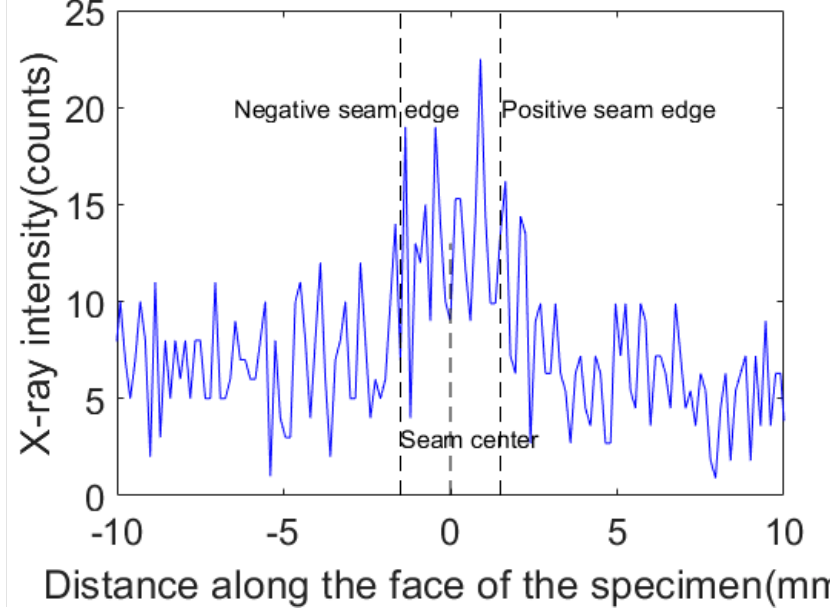
Figure 6. T he X-ray intensity signals at different weld positions in a single scanning period. Figure 6. The X-ray intensity signals at di ff erent weld positions in a single scanning